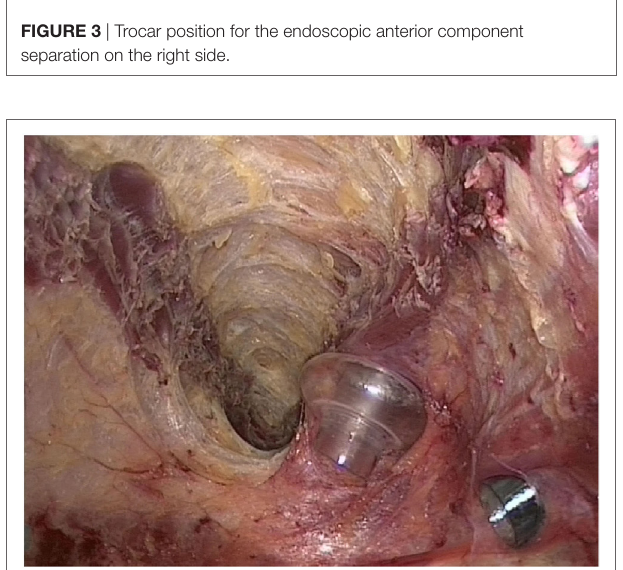
FIgURe 4 | Approximately 5 cm release of the oblique external muscle at the level of the costal arch.